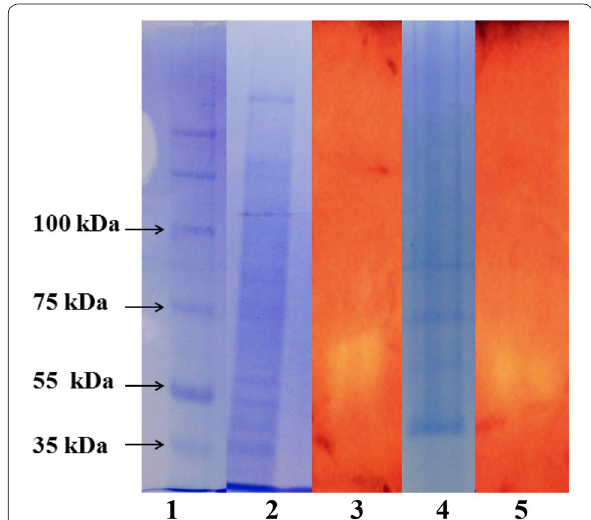
Fig. 3 SDS-PAGE analysis and zymography: (1) Protein Ladder, (2) SDS-PAGE of crude cellulase, (3) zymography of crude cellulase, (4) SDS-PAGE of partially purified cellulase enzyme by ATPS with PEG 8000/MnSO 4 system, (5) Zymography of the partially Purified cellulase enzyme by ATPS with PEG 8000/MnSO 4 system. CMC was used as substrate in